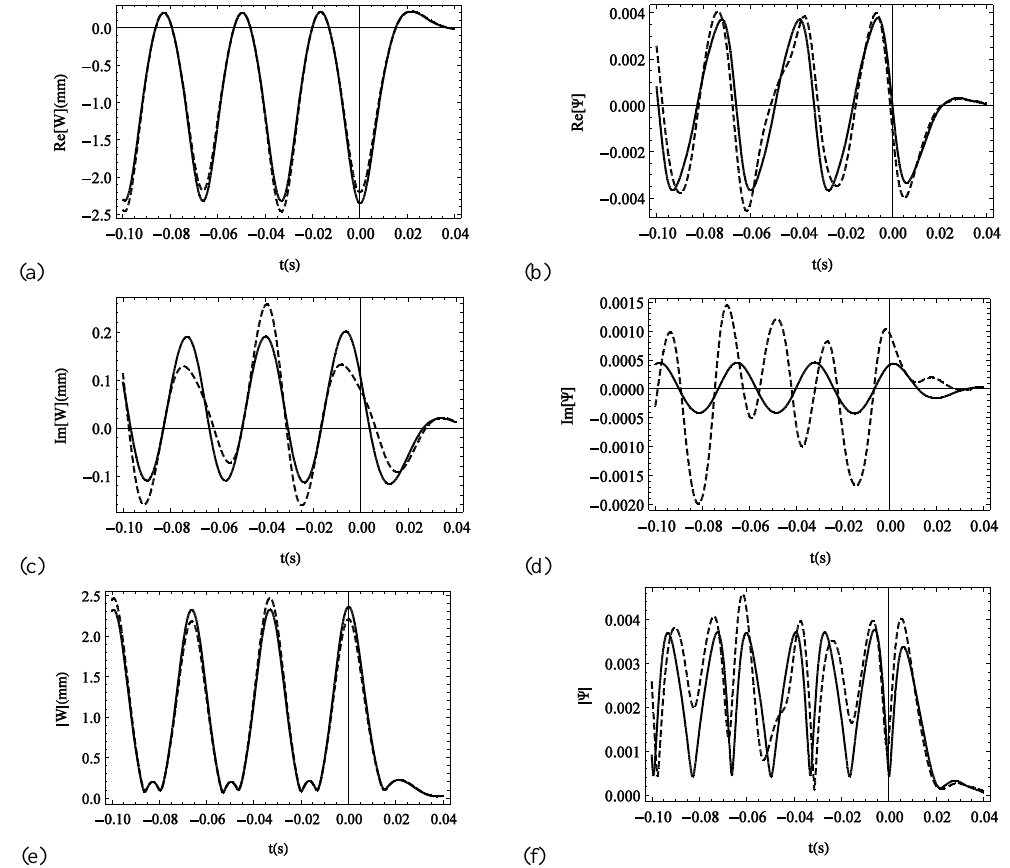
Fig. 7. A comparison of linear and nonlinear response ( 5 f   Hz, 65 V  m/s): (a), (c), (e) 0 W − solid line, 5 W S − dashed line; (b), (d), (f)  − dashed 0  − solid line, 5 S